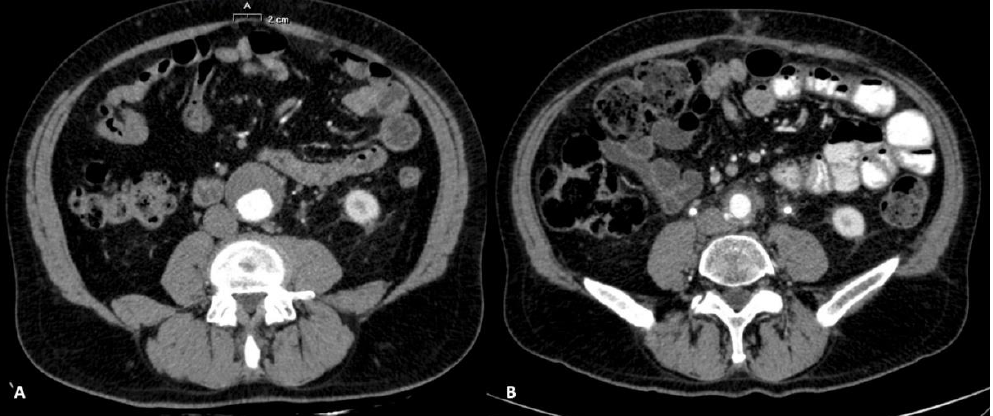
Figure 1. Contrast-enhanced arterial-phase CT scan of the aortic aneurysm before (Panel A ) and after surgical correction (Panel B ).